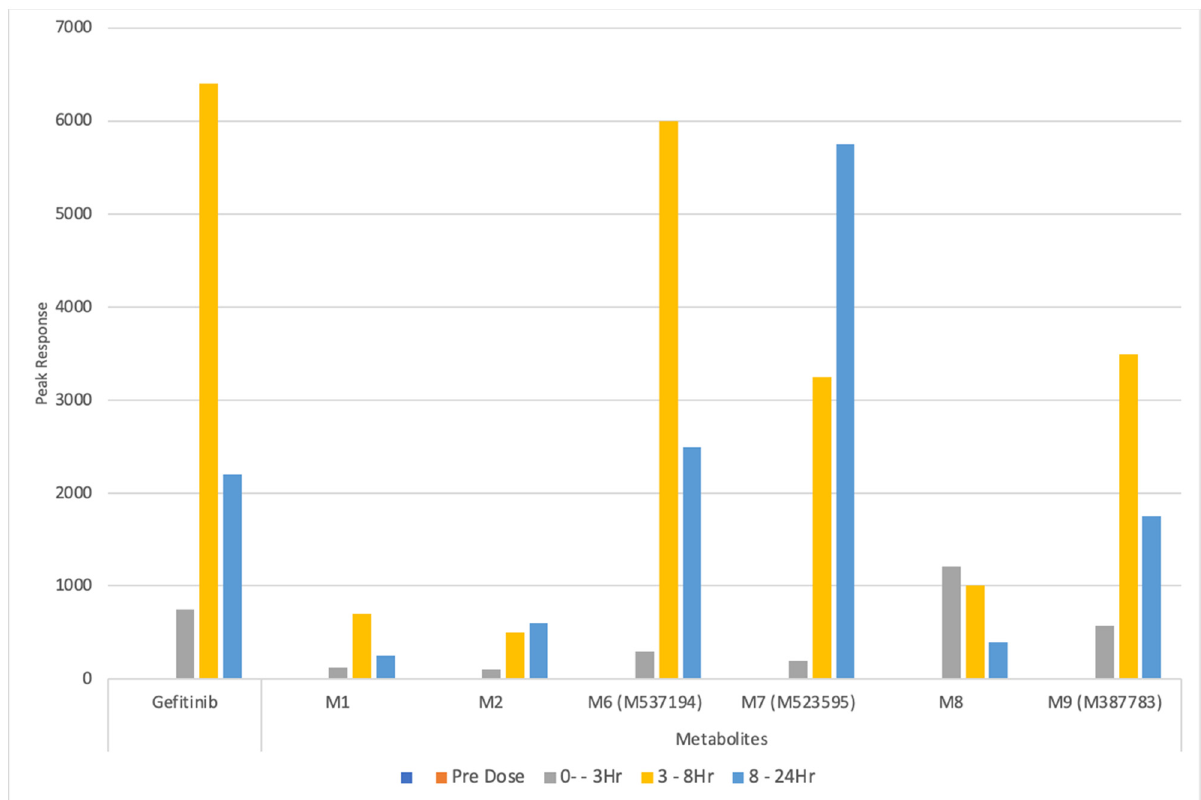
Figure 2. Relative amounts (based on peak response) for gefitinib and selected metabolites in the urine of IV dosed mice for the time points obtained from pooled pre-dose (orange) and 0–3 h (grey), 3–8 (yellow), and 8–24 h (blue) post-dose samples [14]. As indicated, no signals for gefitinib or its metabolites were detected in the pre-dose samples, while the relative rates of excretion of the drug and its metabolites showed compound-dependent profiles. The pharmacokinetic (PK) plasma profiles reported in [14] for gefitinib, M605211, and the O-desmethyl metabolite M7 (M523595) are provided in Figure S1.